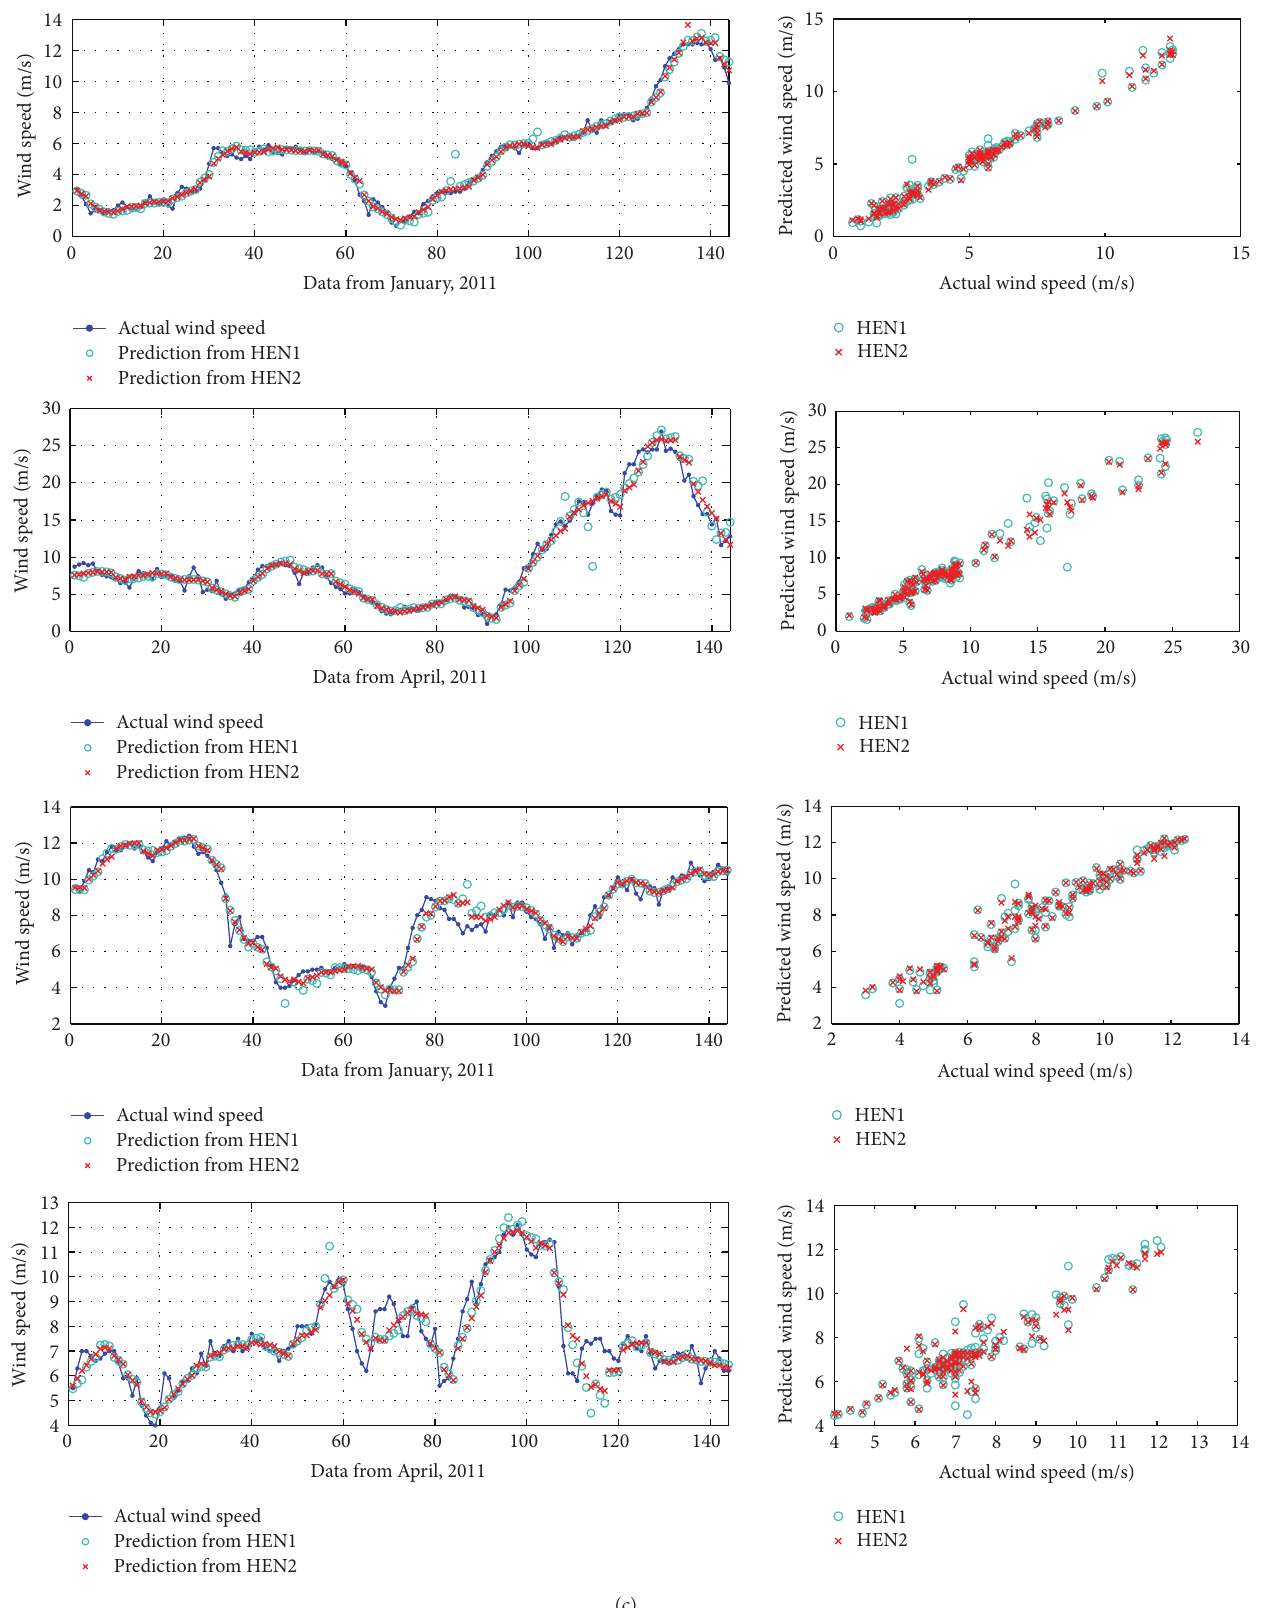
Figure 8: (a) Results of hybrid approaches for Station 1. (b) Results of hybrid approaches for Station 2. (c) Results of hybrid approaches for Station